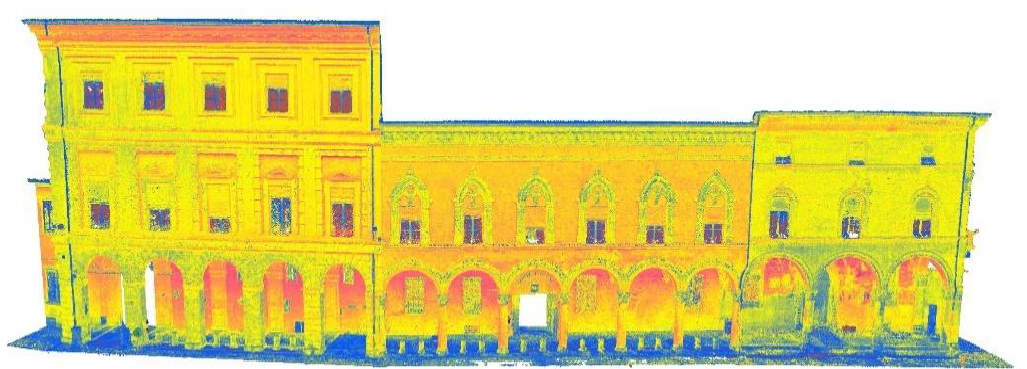
Figure 5. Use of the colour component b* to facilitate the distinction between the windows and walls.